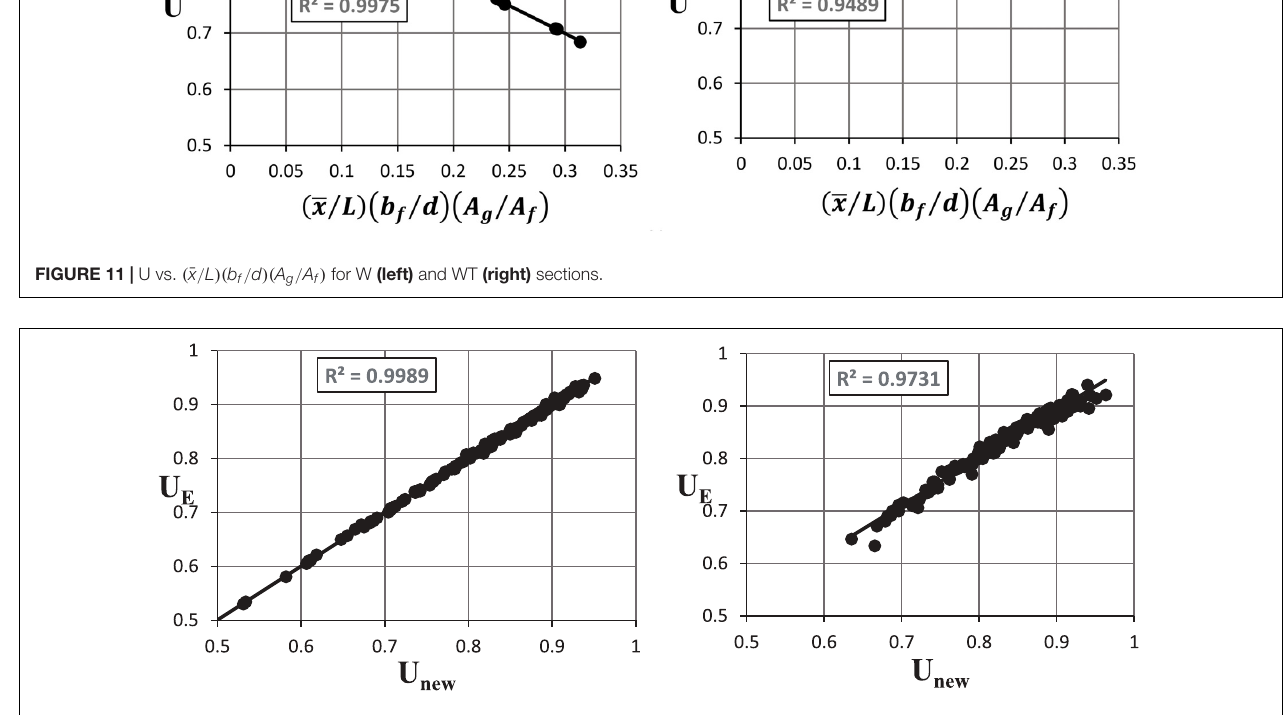
FIGURE 12 | U E (FEA) vs. U new (proposed) for W (left) and WT (right)